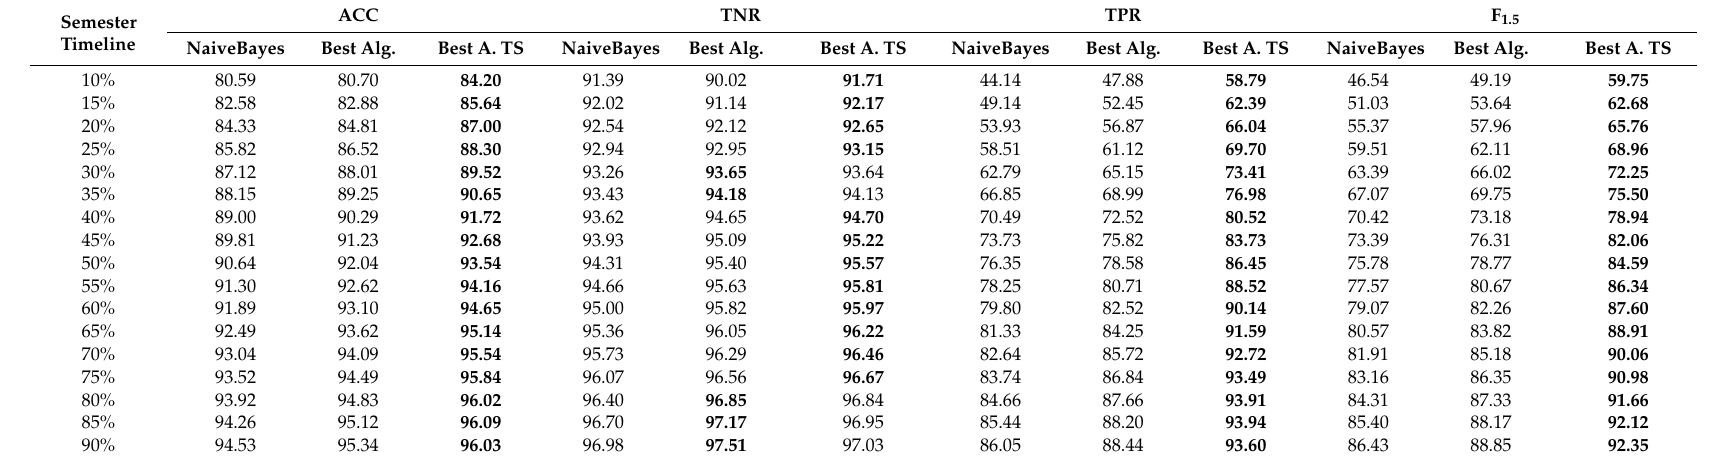
Table A2. LOESS Regression of the Naive Bayes and methods to select the best algorithm classifier and training set in Semester